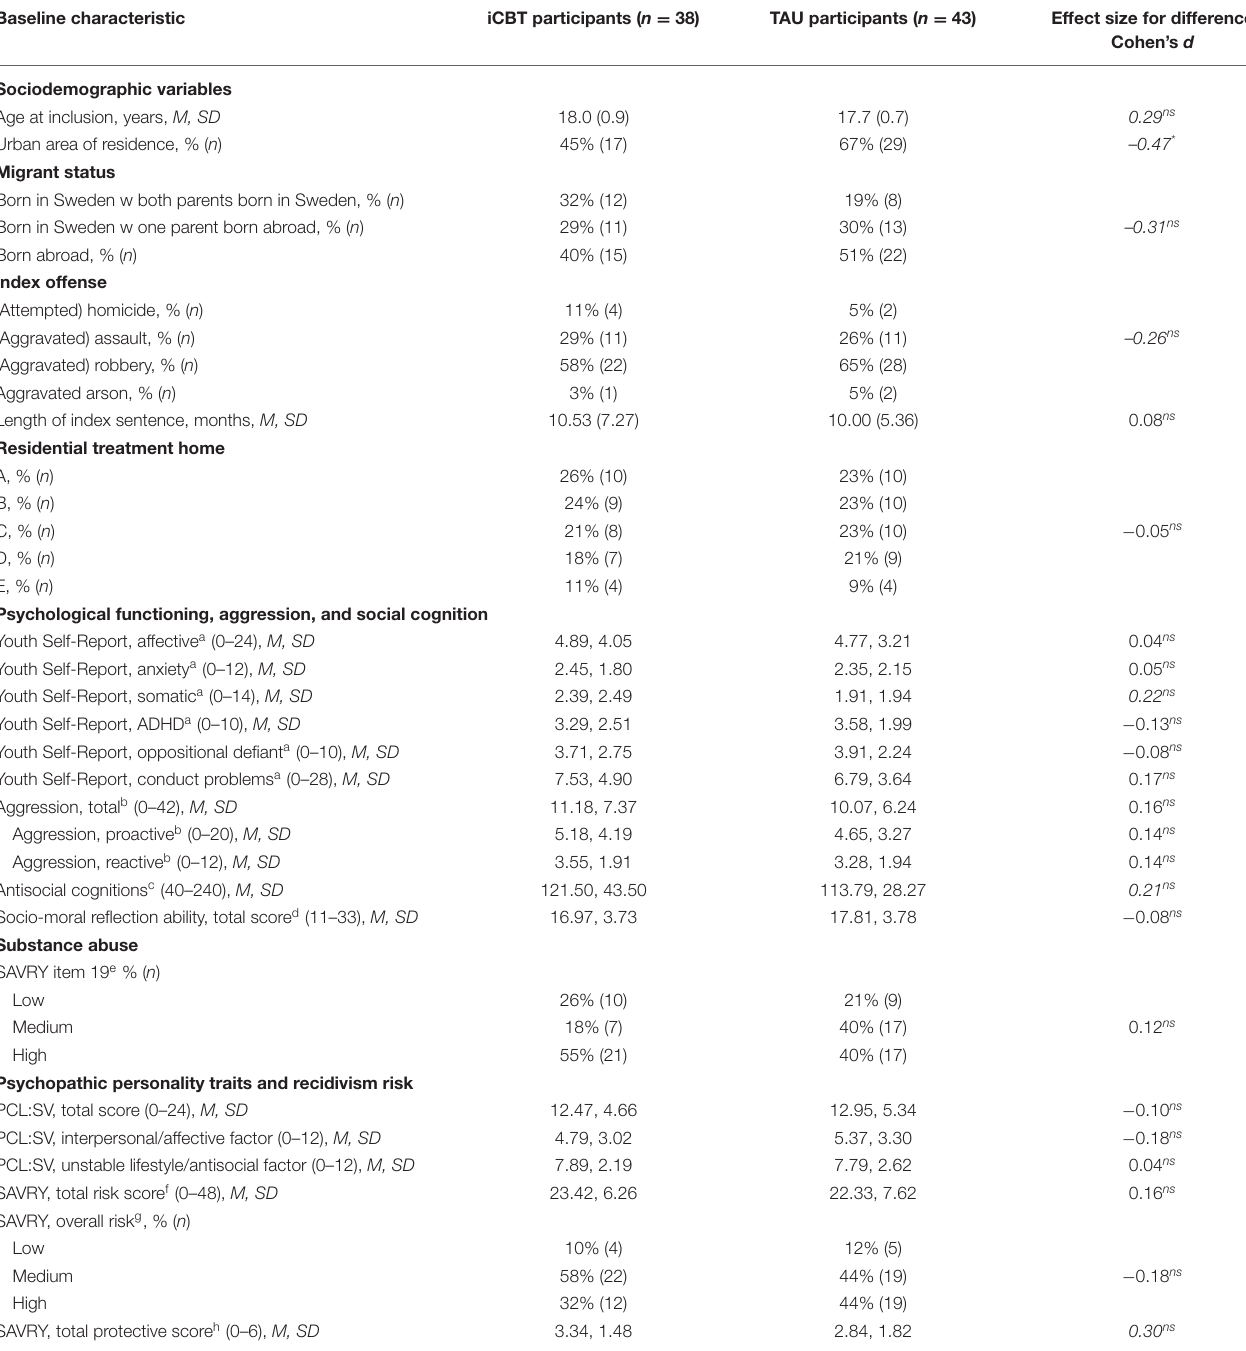
TABLE 1 | Baseline sociodemographic and pre-treatment data for participants in an RCT of an individualized CBT intervention (iCBT) plus treatment-as-usual (TAU) vs. TAU-only among convicted serious, young male violent offenders. Baseline